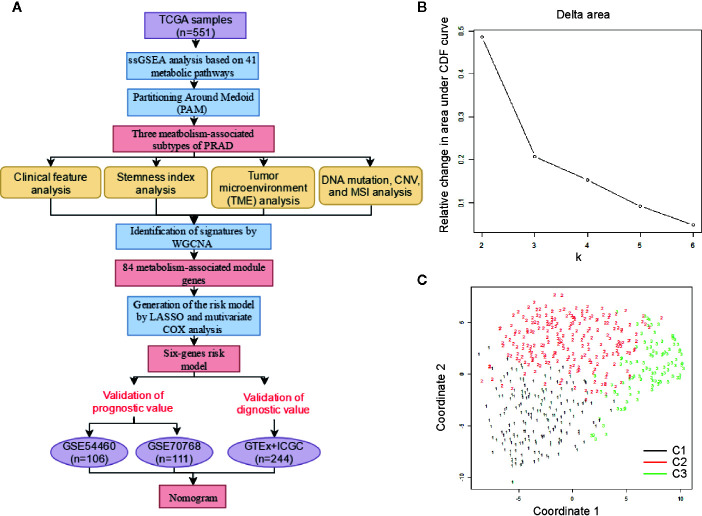
Identification of metabolism-associated subtypes of PRAD using PAM algorithm based on ssGSEA score. (A) Workflow in this study. (B) Delta area curves for consensus clustering indicating the relative change in area under the cumulative distribution function (CDF) curve for each category number k compared to k − 1. The horizontal axis represents the category number k, and the vertical axis represents the relative change in area under CDF curve. (C) t-SNE analysis supported the stratification into three metabolism-associated subtypes of PRAD.